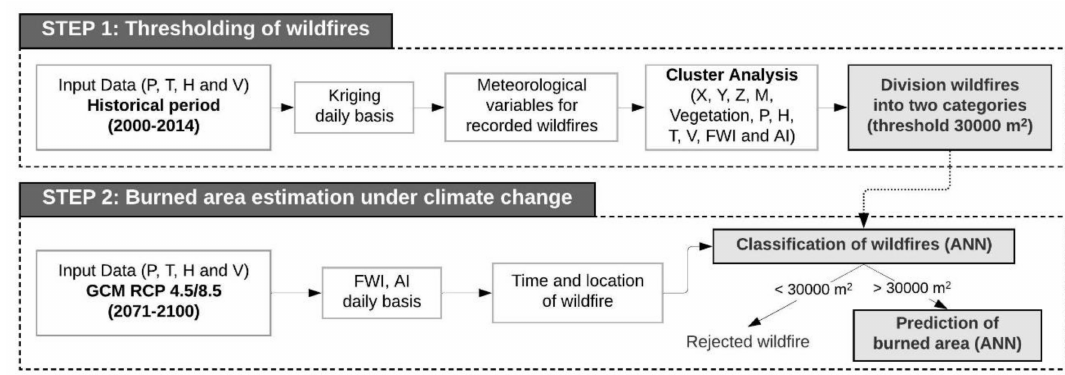
Figure 3. General flowchart of the methodology.